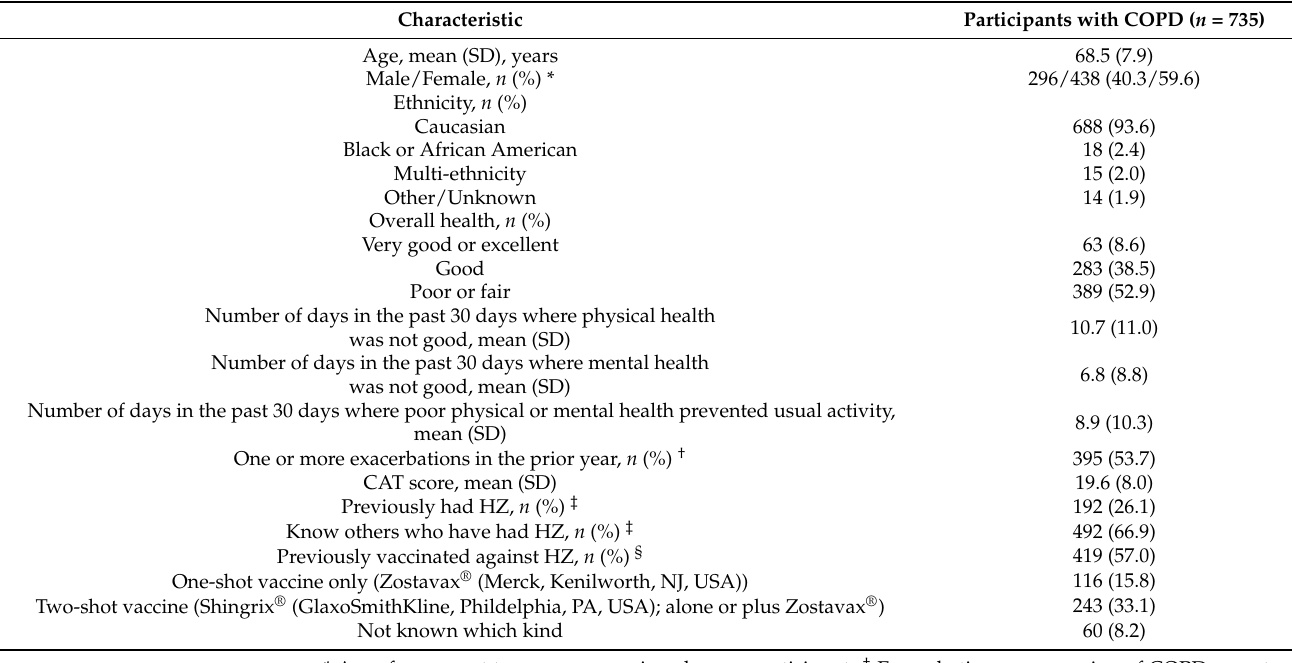
Table 1. Demographics and clinical characteristics for participants with